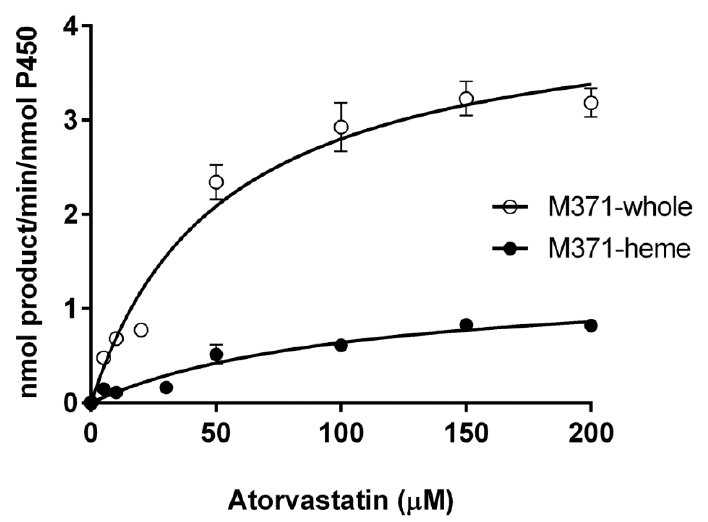
Figure 4. Kinetic parameters of atorvastatin 4-hydroxylation by whole M371 and M371-heme in the presence of H 2 O 2 . The reactions include 5–200 µ M atorvastatin substrate and 0.20 µ M of CYP102A1 M371 whole enzyme ( ) or heme domain in 100 mM of a potassium phosphate buffer (pH 7.4) ( • ). (cid:35) We added 10 mM H 2 O 2 to initiate the reaction, which was incubated for 5 min at 37 ◦ C.